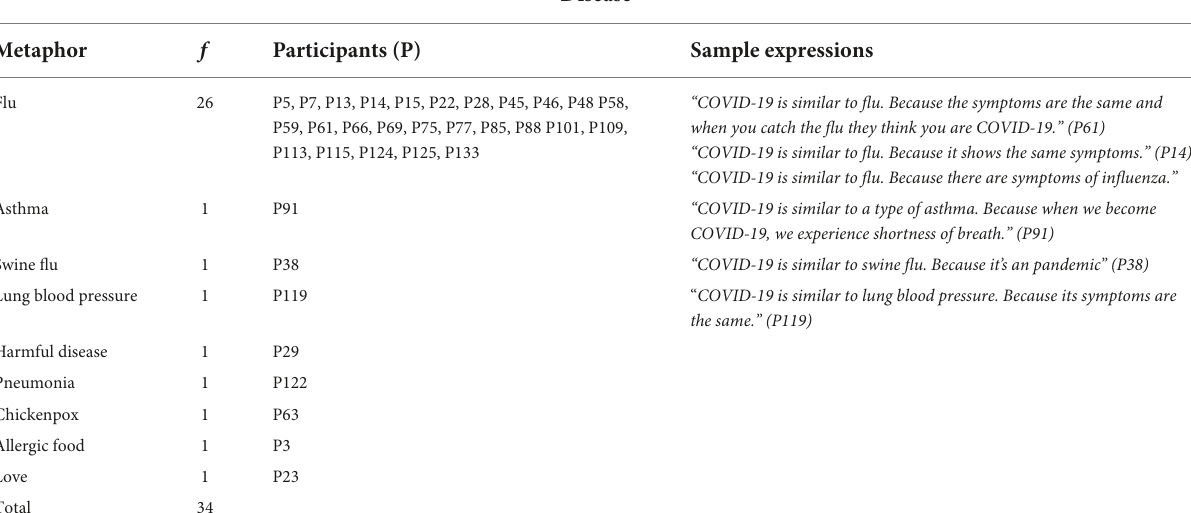
TABLE 4 Disease category.